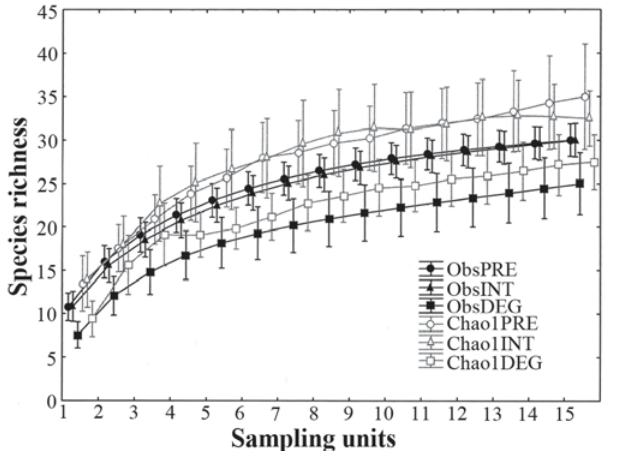
Fig. 3. Sample-based rarefaction curve (Obs) and richness estimation curves (Chao 1) by 50 randomizations against cumulative samples of the preserved (PRE), intermediate (INT), and degraded (DEG)